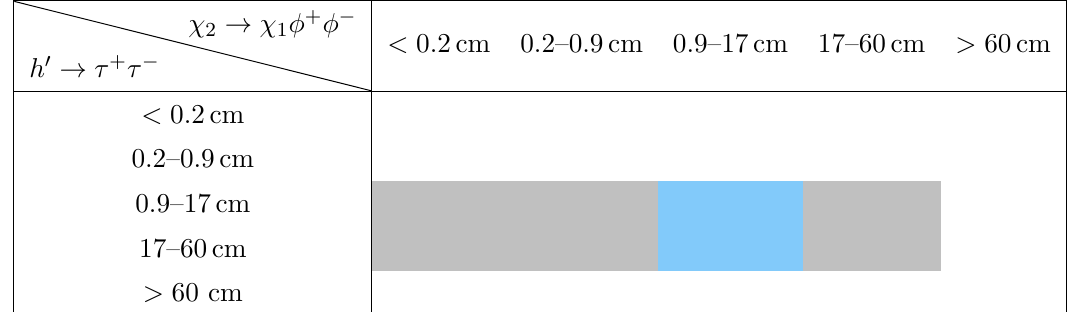
Table 3 . Decay vertex regions for different values of radial displacement for h 0 → τ + τ − used for the region selection : in the gray region all χ